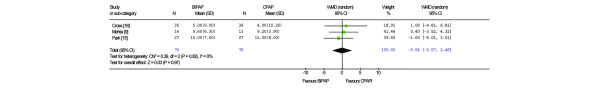
Forest plot: effect of BiPAP and CPAP on length of hospital stay. BiPAP, bi-level positive airway pressure; CI, confidence interval; CPAP, continuous positive airway pressure; WMD, weighted mean difference.